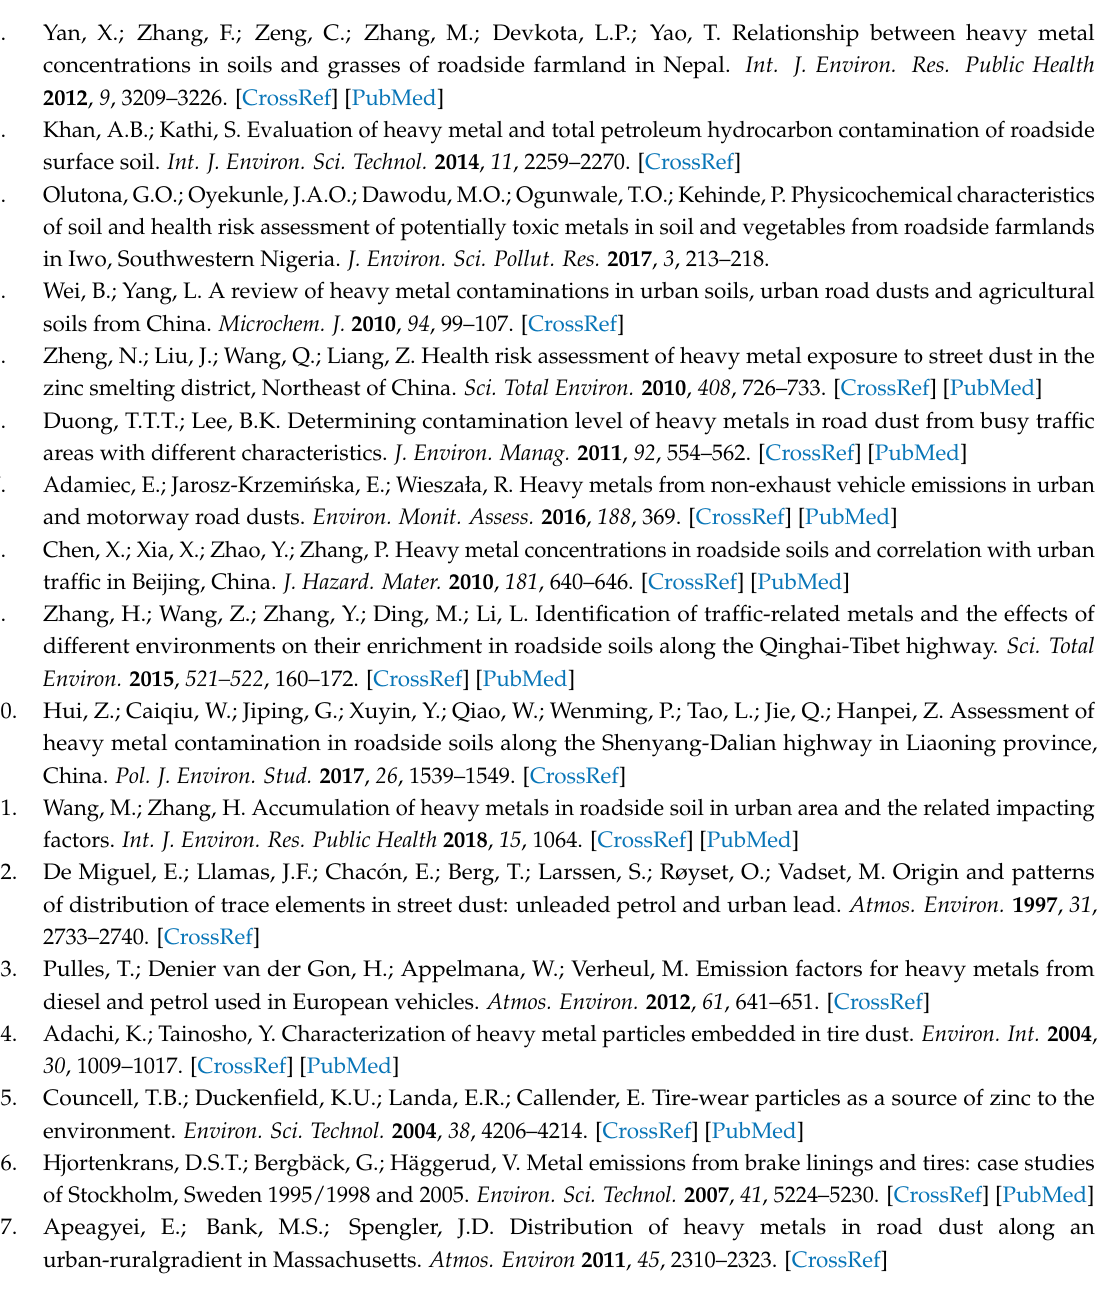
Table S1: Details for sampling locations with the crop type, highway number, and traffic density for each highway. Table S2. Some physical and chemical properties of the roadside agricultural